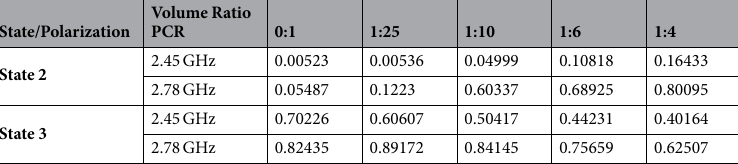
State/Polarization